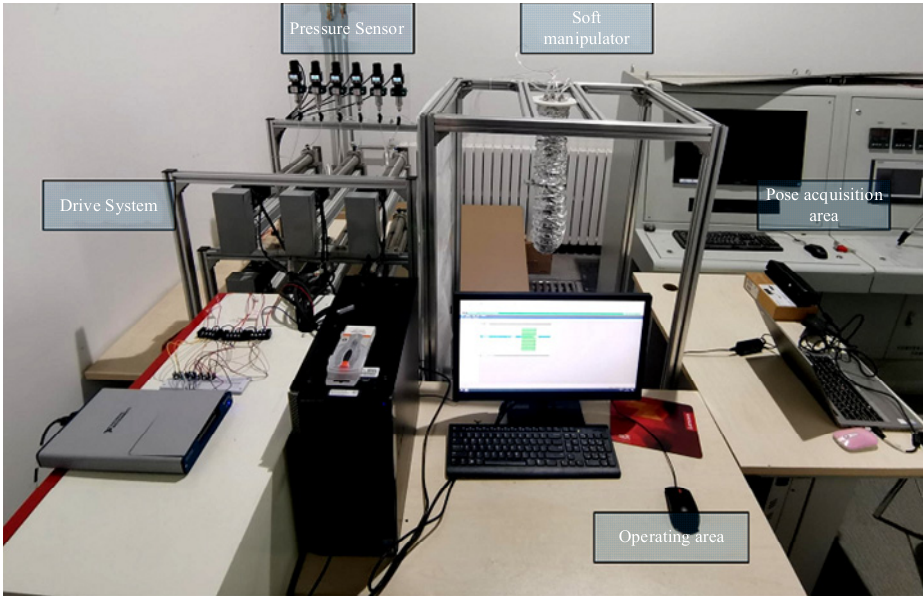
Figure 9. Soft manipulator test platform.